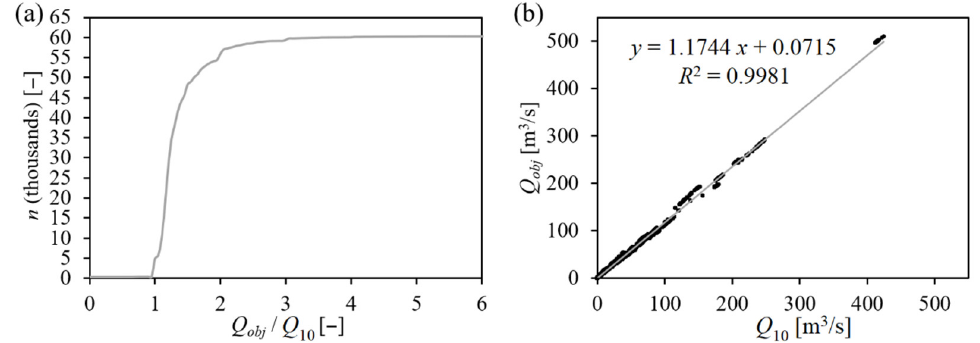
Figure 6. ( a ) Ratio of Q obj to Q 10 in sample and ( b ) linear relation between thresholds.